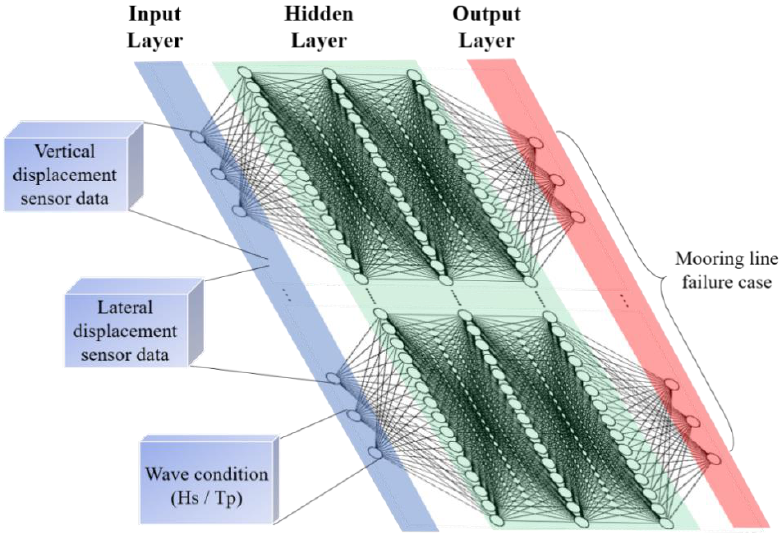
Figure 3. Deep neural network architecture with three hidden layers (although 3 hidden layers are not that deep, it is called DNN in this paper for convenience).